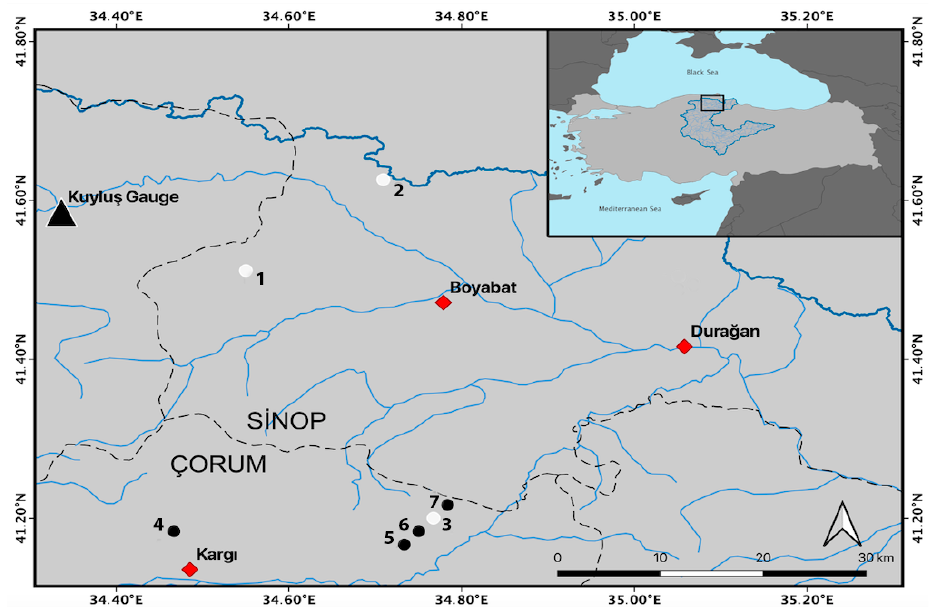
Figure 1. Tree-ring chronology sites in K ı z ı l ı rmak River Basin. The white circles represent the newly sampled sites for this study (1 = HAC, 2 = MEM, 3 = BED), the black circles represent previously published chronologies (4 = KAR, [22]; 5 = IKI, (Akkemik et al. unpublished data); 6 = TIR, [4]; 7 = SAH, [22] and the gray triangle represents the Kuylu ş gauge on K ı z ı l ı rmak River.